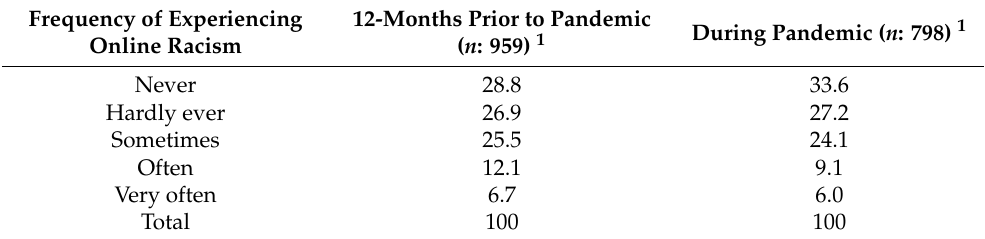
Table 1. Online racism experienced before and during the COVID-19 pandemic